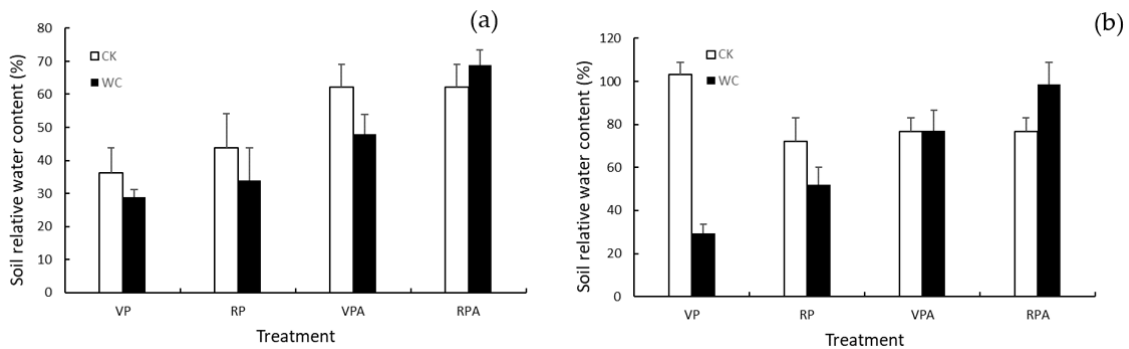
Figure 2. Soil moisture of WC and CK for different treatments in 2019 ( a ) and 2020 ( b ).